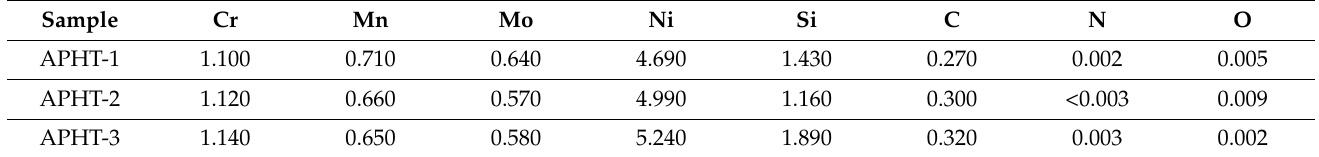
Table 1. Chemical compositions of the ultrahigh strength steel in this study (wt.